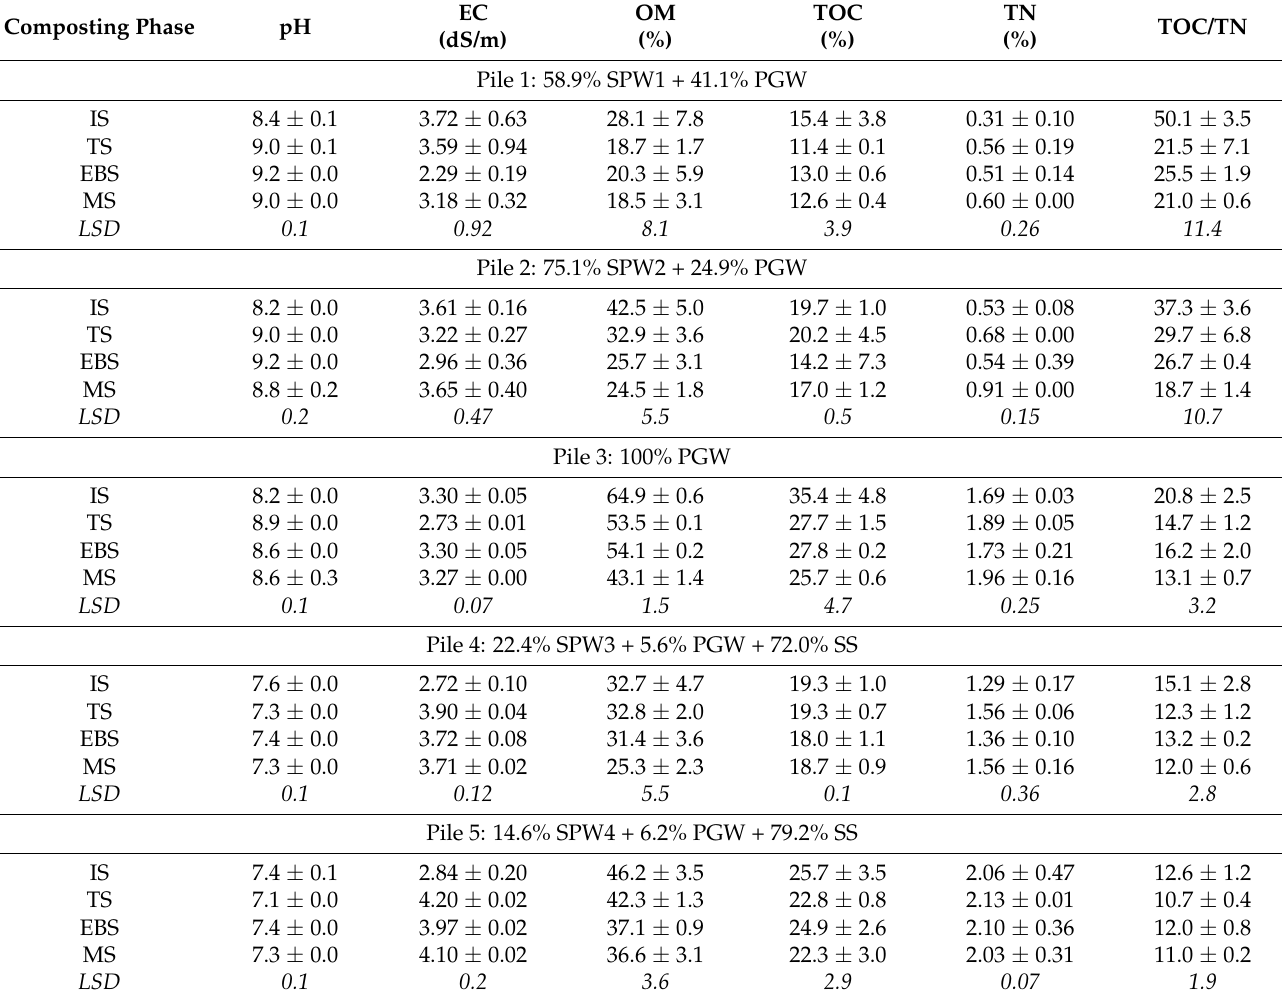
Table 4. Physicochemical and chemical parameters in the initial and final composting samples (data expressed on a dry weight